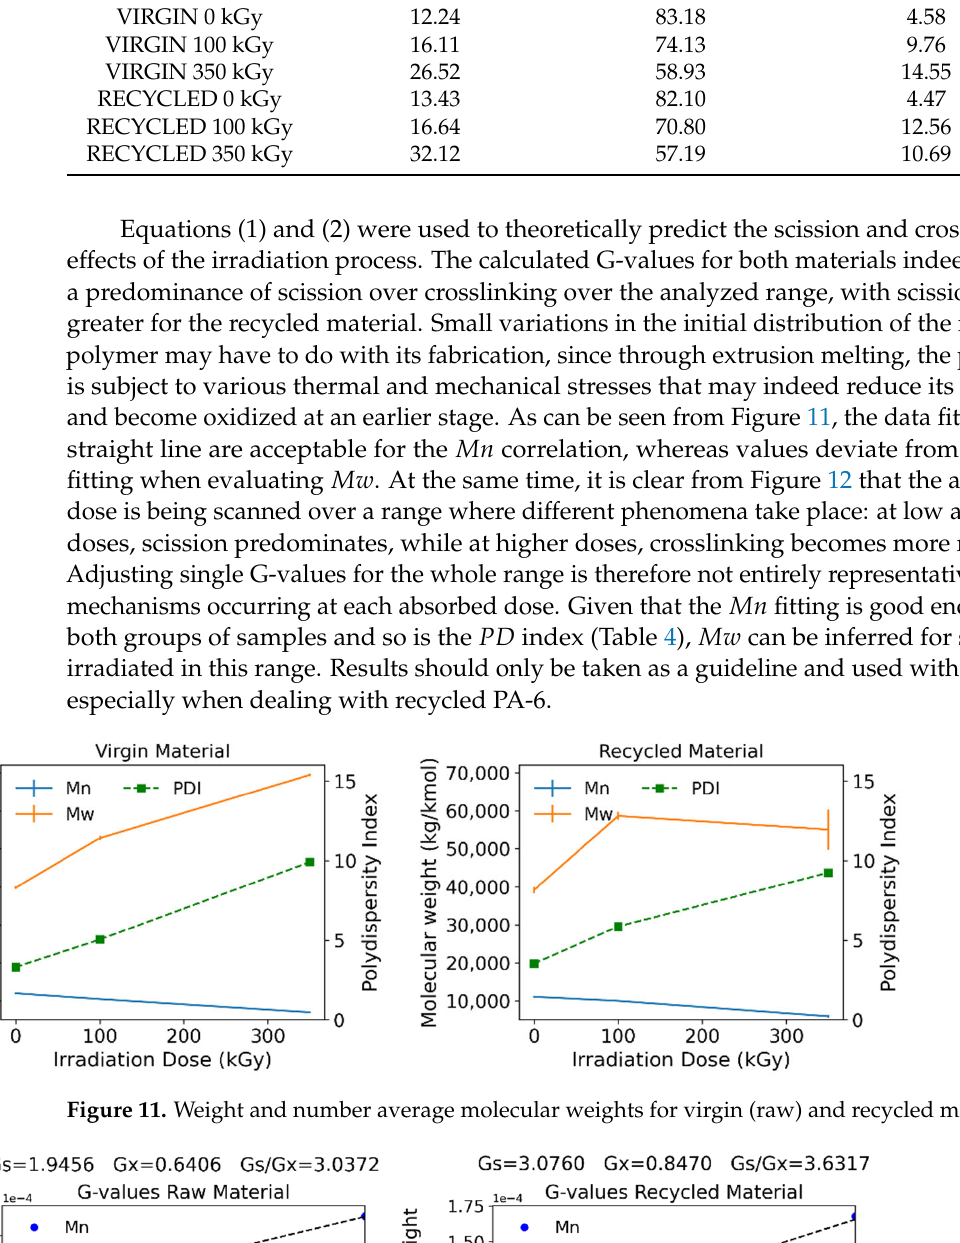
Figure 11. Weight and number average molecular weights for virgin (raw) and recycled material.